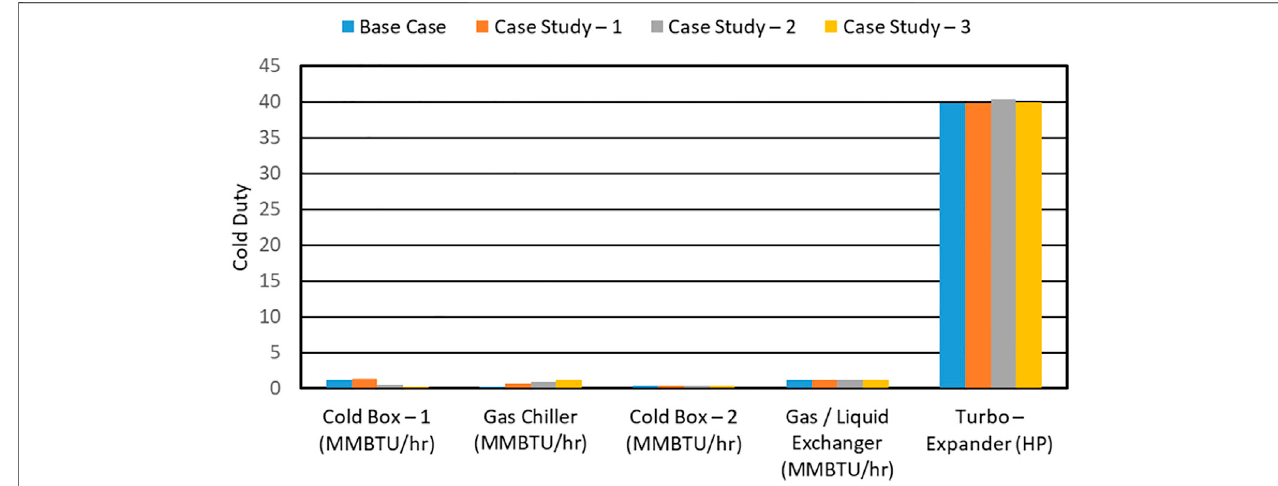
FIGURE 7 | Cold utility duties for coolers, chillers, cold boxes, and refrigerators for the base case and different case studies.